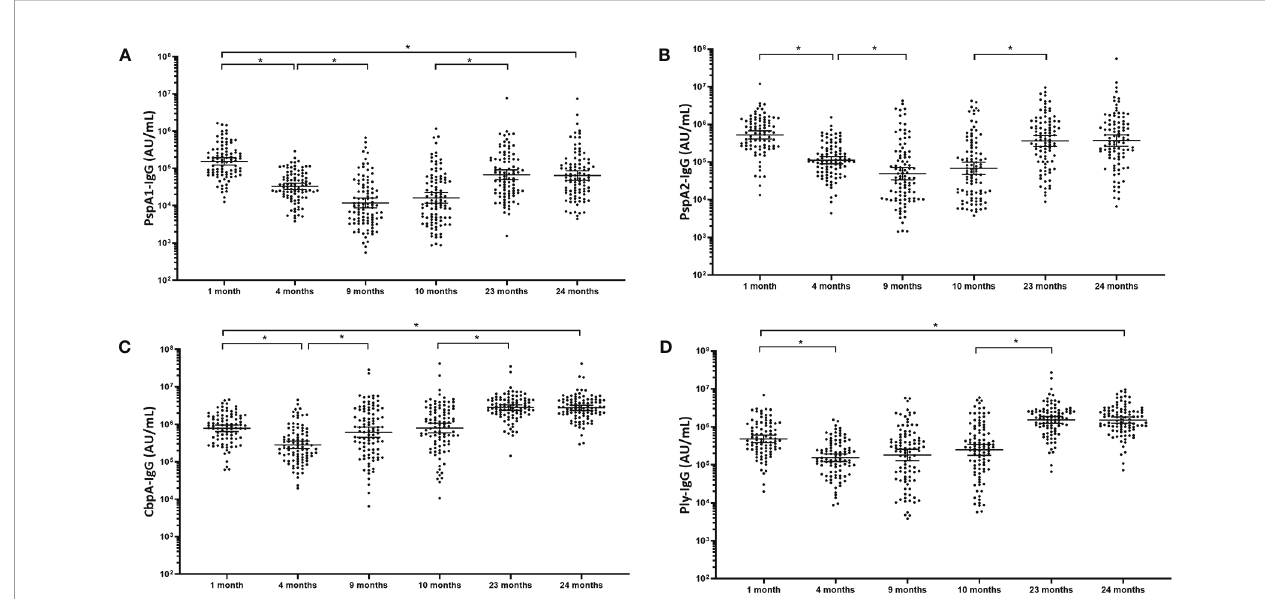
FIGURE 1 | Serum IgG antibodies against pneumococcal proteins waned in the fi rst months of life and returned close to baseline by 2 years of age. Each point represents the serum IgG titres against pneumococcal proteins for a child in AU/mL (A) PspA1, (B) PspA2, (C) CbpA and (D) Ply in children from PNG at different ages. The horizontal bars depict the geometric mean titre (GMT) of IgG at each time-point +/- 95% CI. PspA1, pneumococcal surface protein A family 1; PspA2, pneumococcal surface protein A family 2; CbpA, choline-binding protein A; Ply, pneumolysin. *p-value <0.05, statistical analyses were conducted on the logarithmically transformed data. All children had measurable antibody